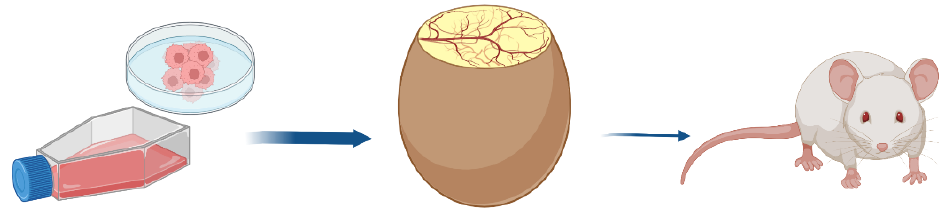
Figure 1. The egg before the mouse.